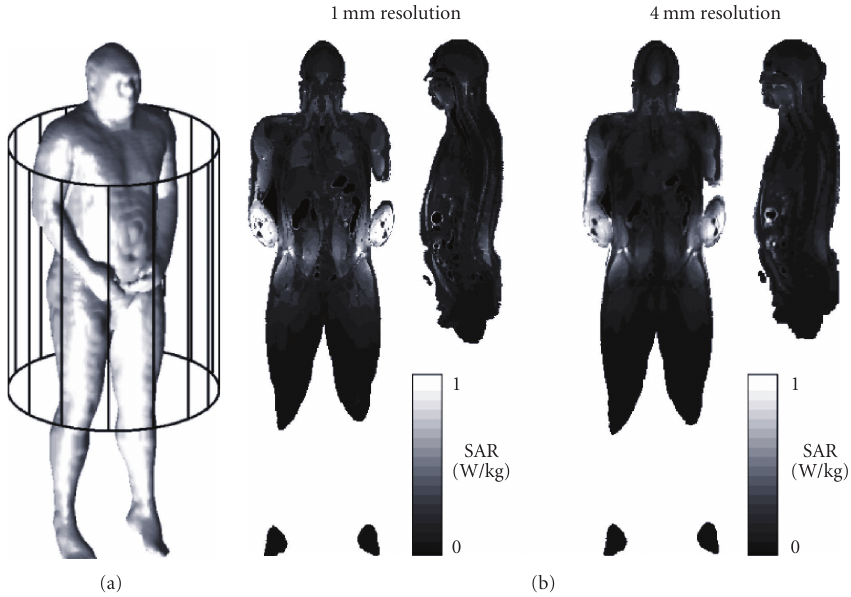
Figure 5: (a) Model setup involving the whole-body birdcage resonator and the body model, (b) coronal and sagittal profiles of in situ SAR spatial distributions in the male Brooks Airforce model (BROOK) at 1 mm and 4mm voxel resolution.